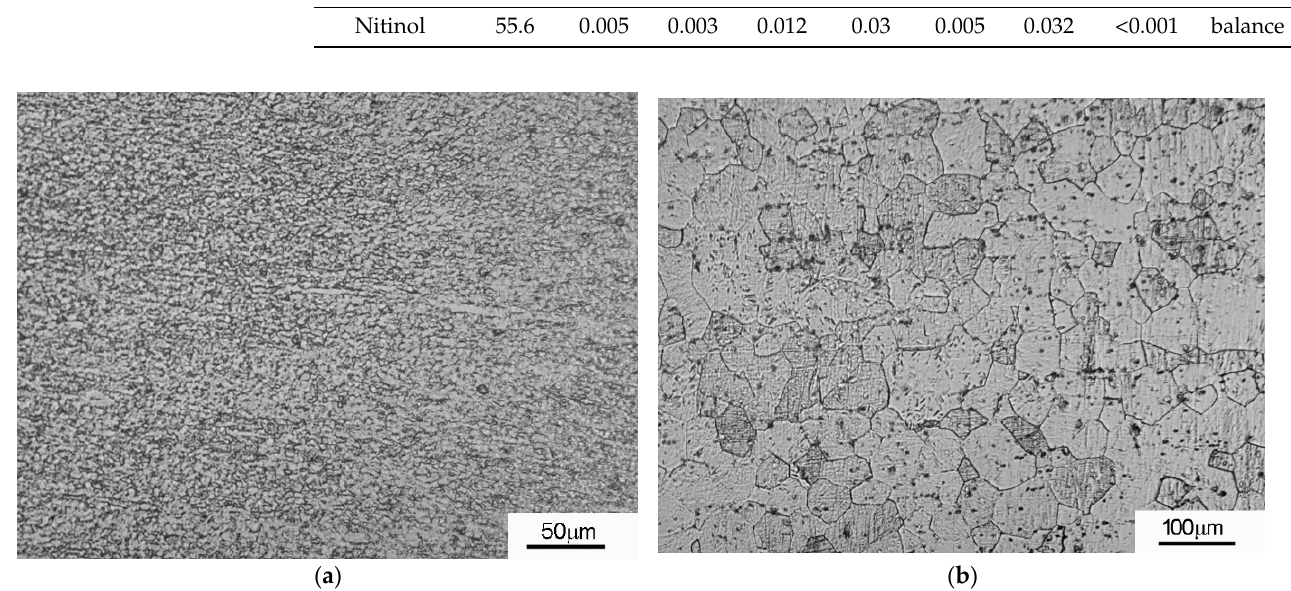
Table 1. Composition of base metals (wt %).